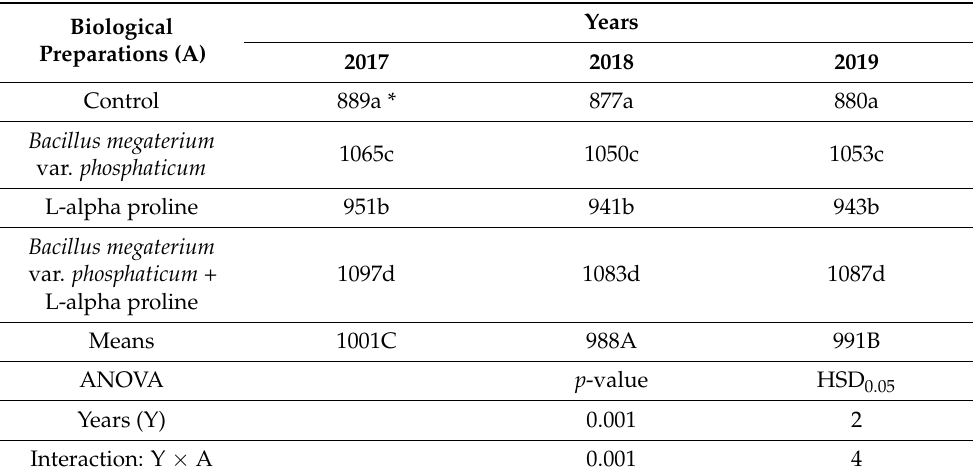
Table 2. Fe content in the arable layer of soil 30 days after the application of biological preparations in 2017–2019, mg · kg − 1 of soil.